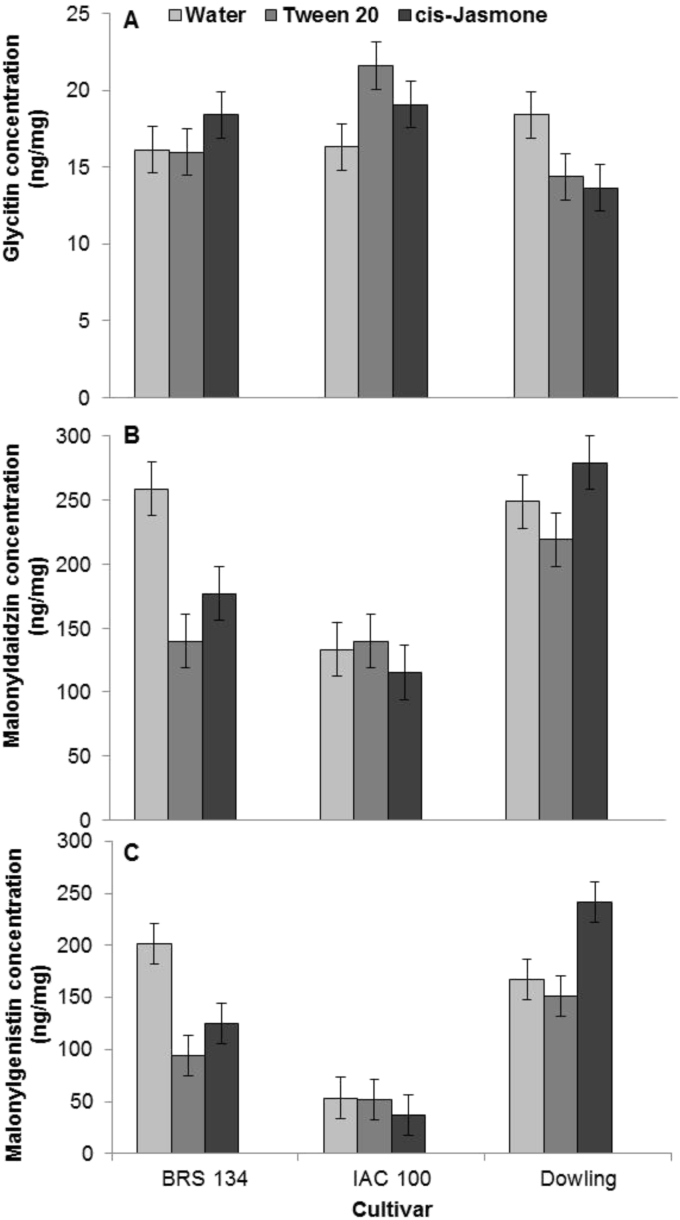
Concentrations of glycitin (A), malonyldaidzin (B) and malonylgenistin (C) in seeds removed from pods of soybean cultivars BRS 134, IAC 100 and Dowling, after H2O, Tween 20 and cis-jasmone spray treatment, considering the cultivar by treatment interaction for these isoflavonoids (P < 0.001, Table 2). Mean ± LSD. SED: 1.54 (Glycitin); 21.30 (Malonyldaidzin); 19.74 (Malonylgenistin), are shown; replication, n = 30.